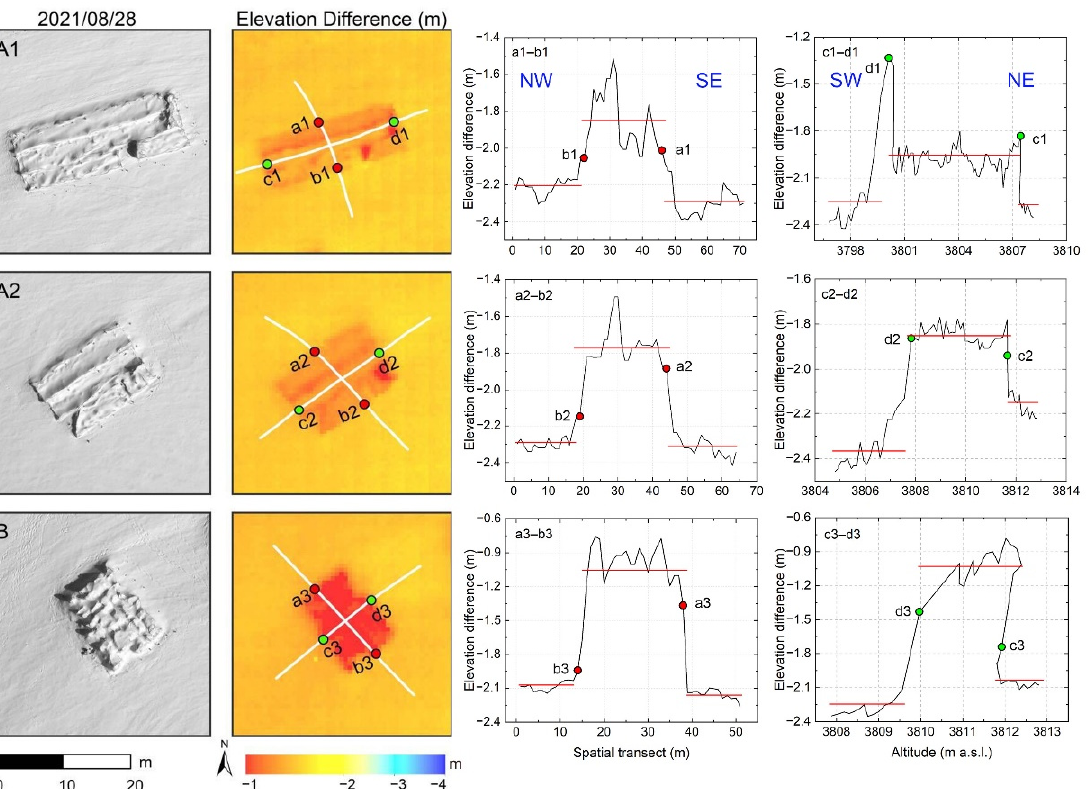
Figure 5. Detailed change in the selected area of UG1. Ortho-mosaic on 28 August 2021 ( left panel), elevation changes between 24 June and 28 August 2021 ( middle panel), and spatial transect differences for elevation change ( right panel). ( A1 , A2 ) were the geotextile-covered areas. ( B ) was the nanofiber-covered area. Table 1. Mean elevation of the profiles. The mean ( µ ) and standard deviation ( σ ) of glacier elevation changes as well as absolute differences (abs. diff) of the experimental area (exp) values to the refer- ence area (ref) values are listed.